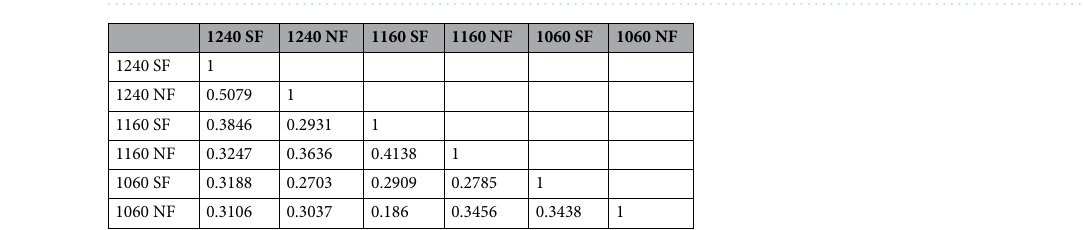
Figure 4. Hierarchical classification of the different belts, in site II, based on their floristic structure (incidence data), by using Ward’s method and Euclidean distances as measurement of Linkage Distance. Elevation value = m.a.sl., N, north facing; S, south facing.